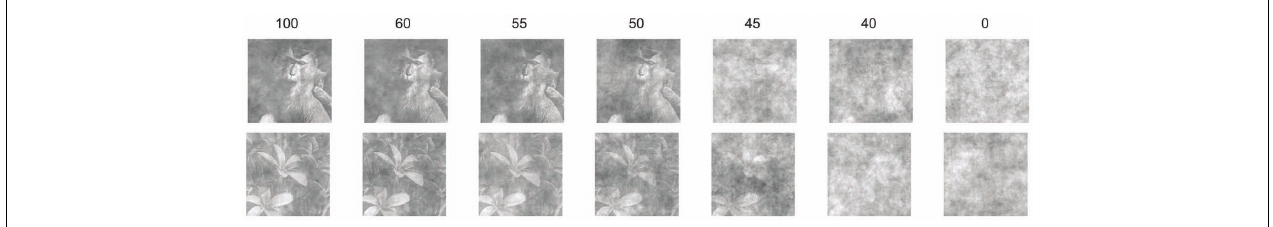
FIGURE 2 | Parametric interpolation with random phases of one monkey and one flower exemplar. Numbers on top of each image refer to % coherence. At 0 level, the image therefore contains only